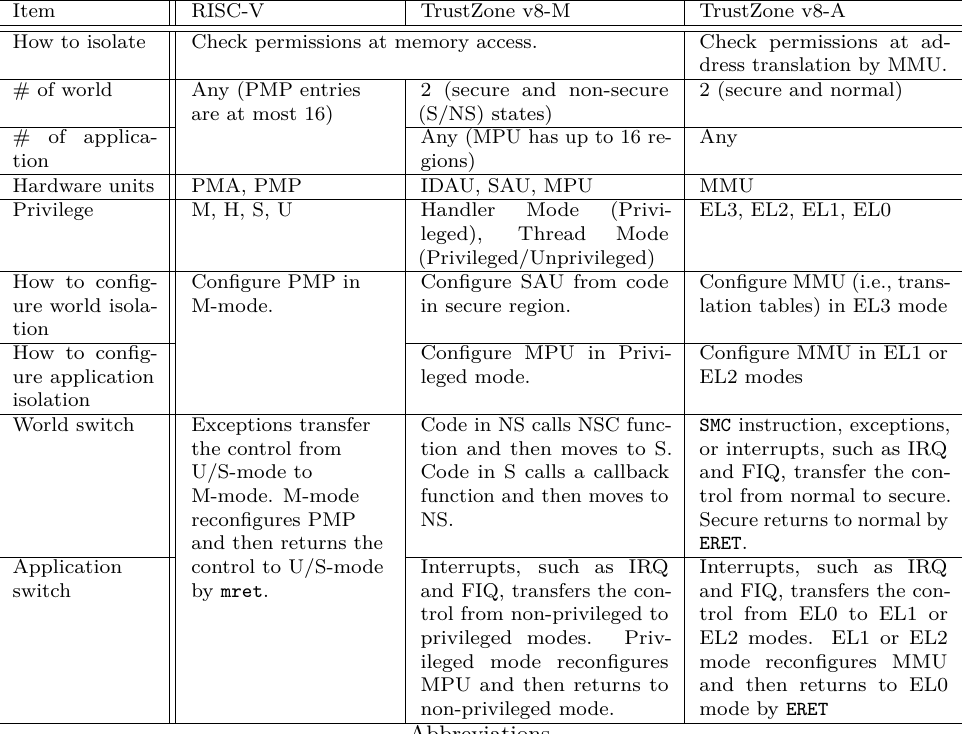
Table 11: Comparison of RISC-V and